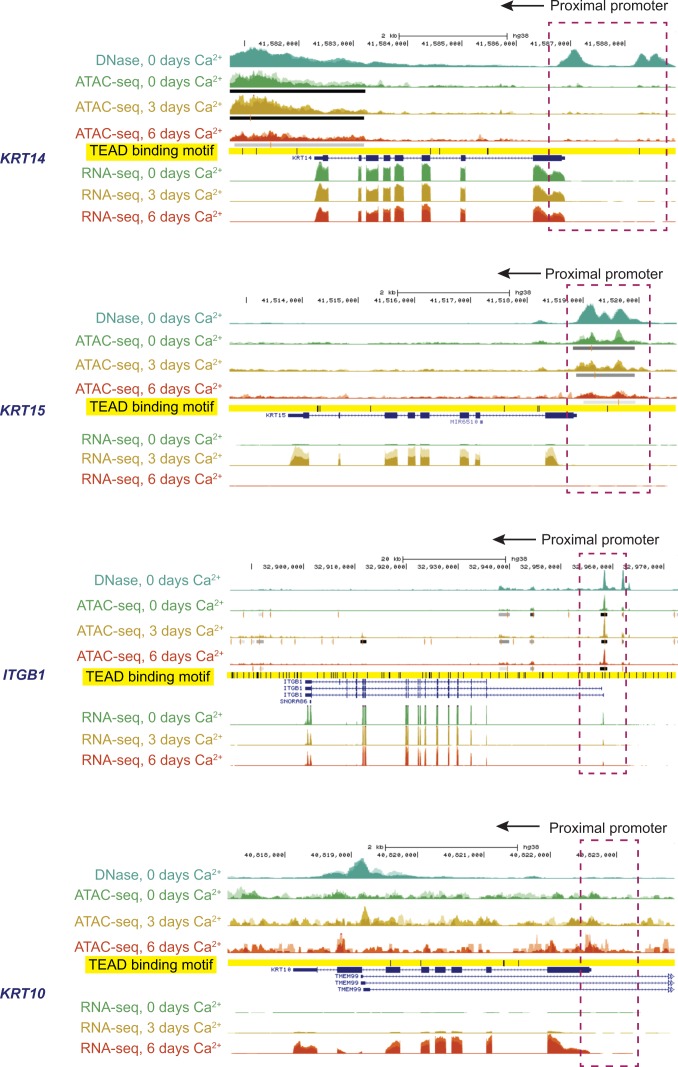
Genomic context, gene expression, chromatin organization, and presence of TEAD binding sites in gene loci of interest.This information was obtained from the ENCODE project (www.encodeproject.org) and applies to human fore-skin keratinocytes cultured in the presence or absence of calcium (see Materials and methods for details). Representative data from four genes (KRT14, KRT15, ITGB1 and KRT10) are shown. Cells were subjected to calcium treatment for 0, 3 and 6 days. Chromatin structure (e.g., open, closed) was assessed by DNAse treatment at baseline (0 days calcium) or by ATAC-SEQ at 0, 3, and 6 days after calcium treatment. Transcript levels were measured by RNA-seq at 0, 3, and 6 days after calcium treatment. Peak scaling is identical between days 0, 3, and six but optimized between genes. Gene diagrams are shown in blue. The location of TEAD consensus binding sites depicted by short vertical bars and highlighted in yellow. Proximal promoter regions are boxed (dashed lines), and direction of transcription is shown by arrows.